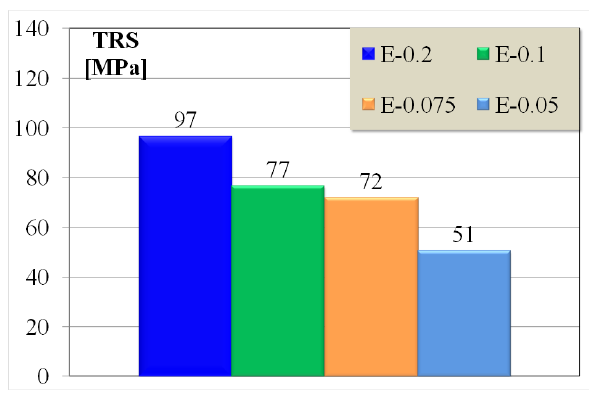
Figure 6: Mechanical strength of epoxy